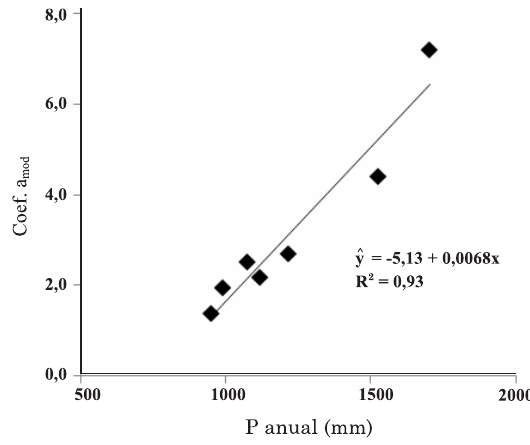
Figura 5. Relação entre o coeficiente a volume de precipitação pluvial anual para o período de calibração do